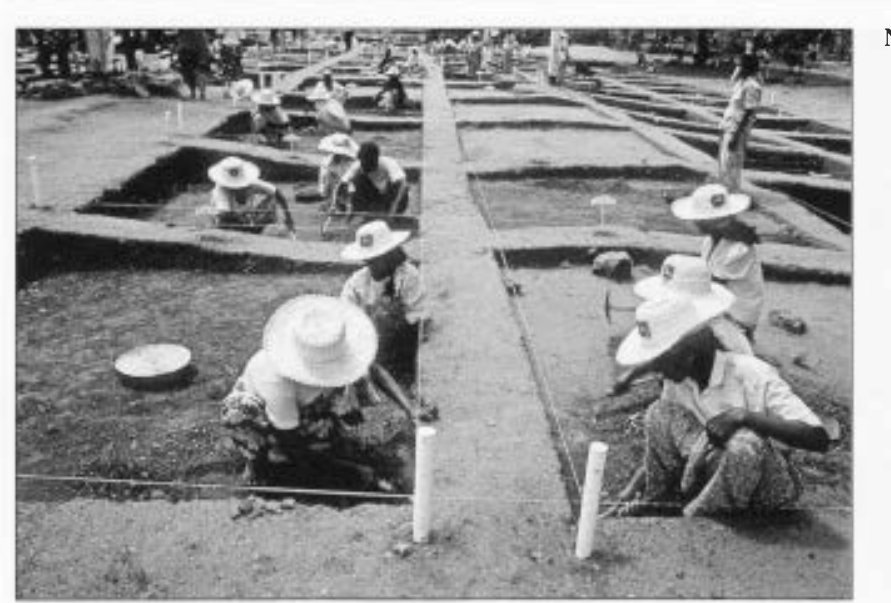
FigureB Excavation on progress at the site of a monasteryatAnuradhapura, Sri Lanka. overcoming national aspirations and prejudices to make t h e List truly represent­ ative of millennia of human achievement.